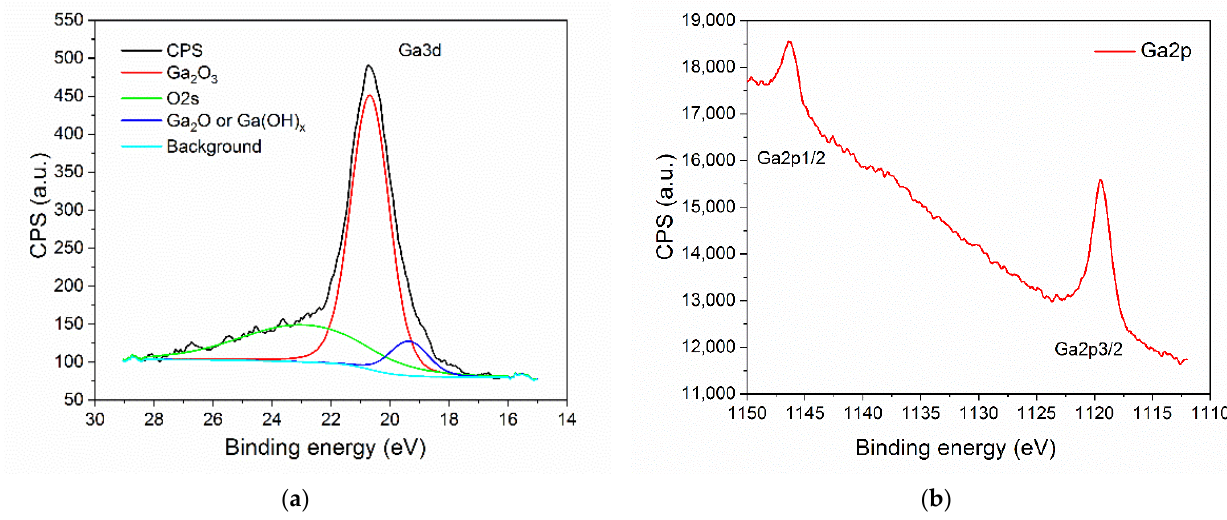
Figure 12. Core-level spectra of: ( a ) Ga3d; ( b ) Ga2p.